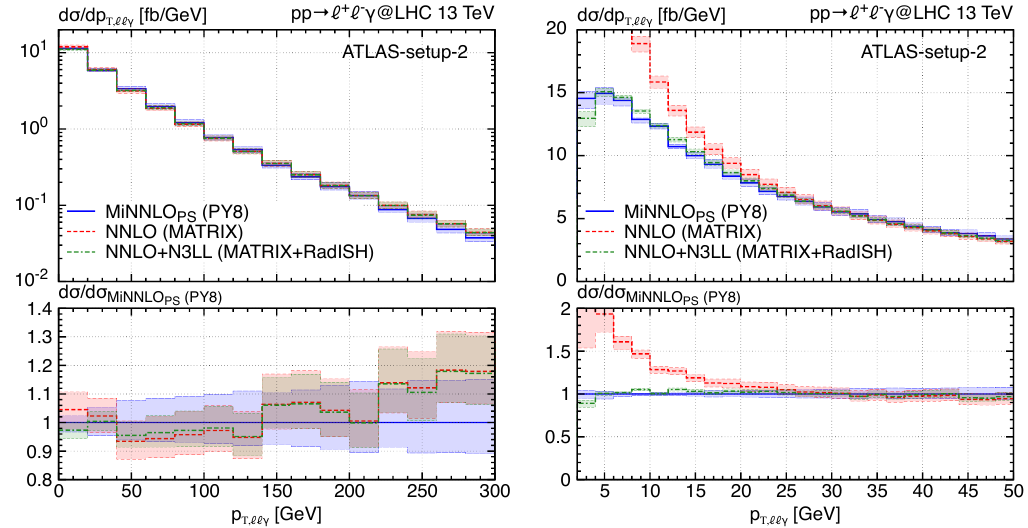
Figure 9. Distribution in the transverse momentum of the Zγ system in a wider range (left plot) and at small p (right plot) for MiNNLO (blue, solid line), NNLO (red, dashed line) and PS T, ‘‘γ NNLO+N 3 LL (green, double-dash-dotted